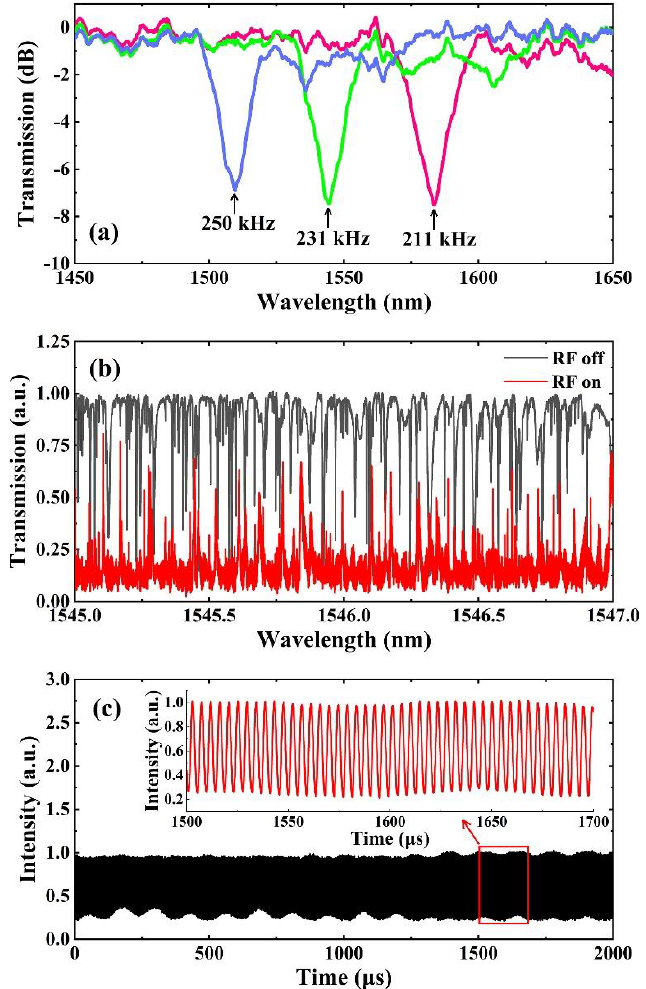
Figure 3. ( a ) The tunability of the AOTF. As the driving frequency increased from 211 kHz to 250 kHz, the resonant notch had a blue shift from 1583.4 nm to 1509.6 nm; ( b ) The transmission of the TF-coupled microsphere with RF off and on, respectively. The black line was the transmission spectrum corresponding to WGM without acoustic wave, while the red line shows the resonant peaks recoupled back into the fiber core with acoustic wave under proper polarization; ( c ) Optical beats without package process. The inset is the enlargement of the optical beats.